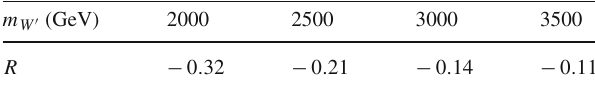
Table 4 The numerical results for the relative corrections of W (cid:2) pre- dicted by the NU model to the decay B − → γ e − ¯ ν e in the up-quark